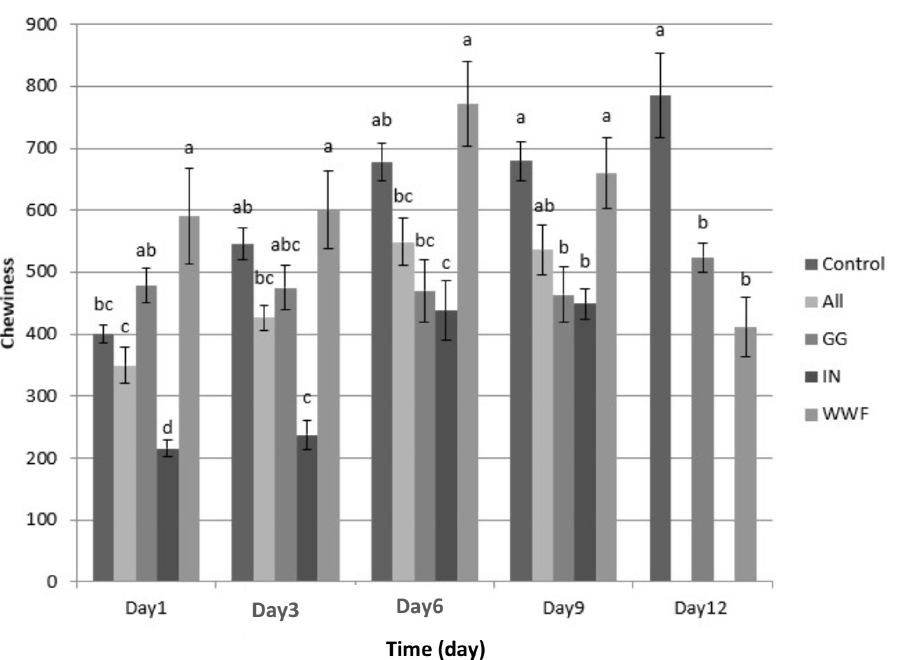
Figure 5. The impact of the added FI on Pita breads Chewiness. The a, b and c letters at each sampling time indicate statistically significant differences ( p < 0.05). Values are mean ± SEM of 6 replicates.